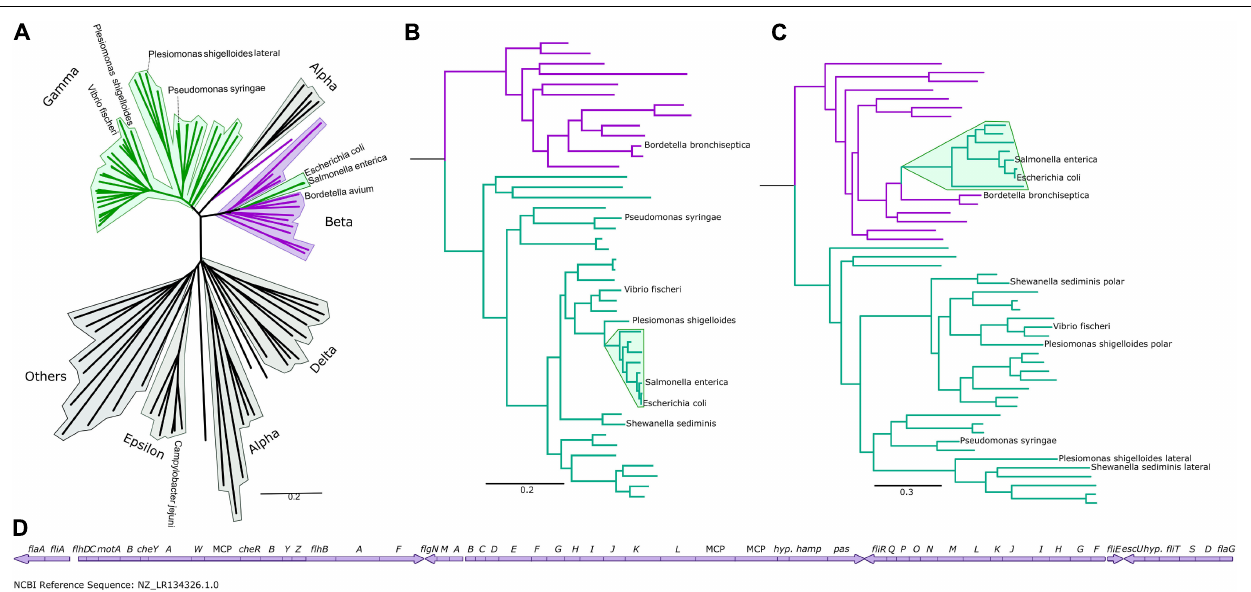
FIGURE 1 | The Enterobacteriaceae have β -like motors. (A) An unrooted global flagellar phylogeny. γ -proteobacteria are highlighted in green: the enteric Enterobacteriaceae γ -proteobacteria ( Salmonella enterica and Escherichia coli) are not clustered with the other γ -proteobacteria, but are clustered within the β -proteobacteria (purple). Fully annotated version of this tree is presented in Supplementary Figure S1 . (B) An organismal phylogeny focused on γ - (green) and β -proteobacteria (purple), rooted with an ε -proteobacterium, Campylobacter jejuni. The Enterobacteriaceae are highlighted in green. Fully annotated version of this tree is presented in Supplementary Figure S4 . (C) The flagellar phylogeny of the γ - (green) and β -proteobacteria (purple). Note the shift in position of the Enterobacteriaceae (highlighted in green) from the γ -proteobacterial clade to within the β -proteobacterial clade. Rooted with Campylobacter jejuni. Fully annotated version of this tree is presented in Supplementary Figure S5 . (D) The Bordetella bronchiseptica flagellar gene cluster is arranged in one continuous genetic